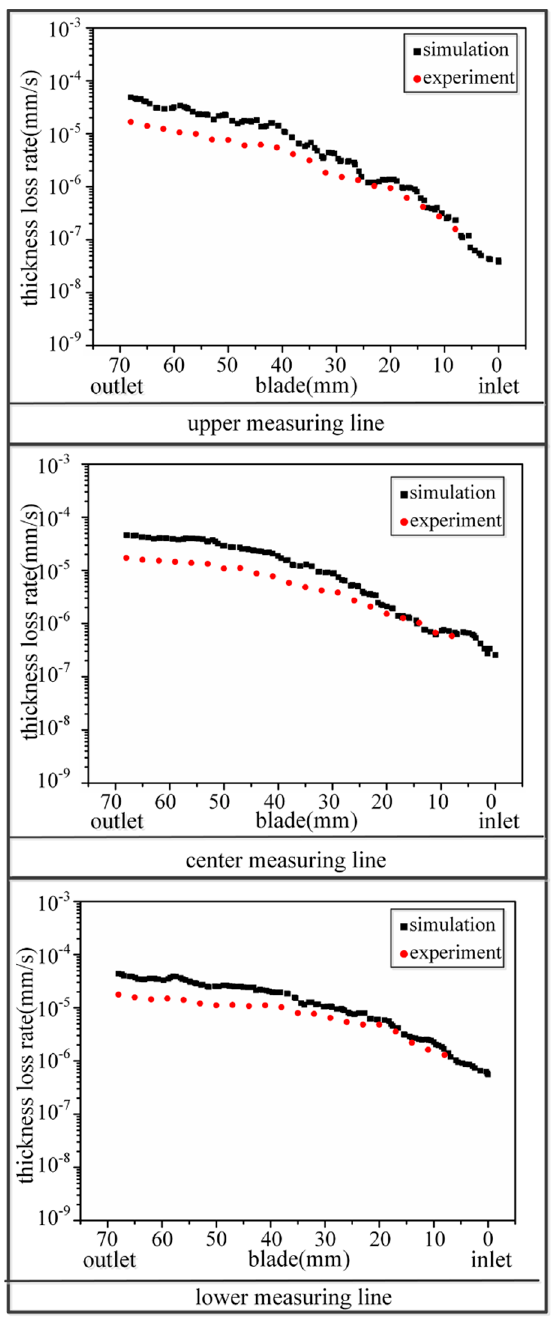
Figure 9. Thickness loss rate of No.1 blade working surface at 500 rpm and 10% concentration.